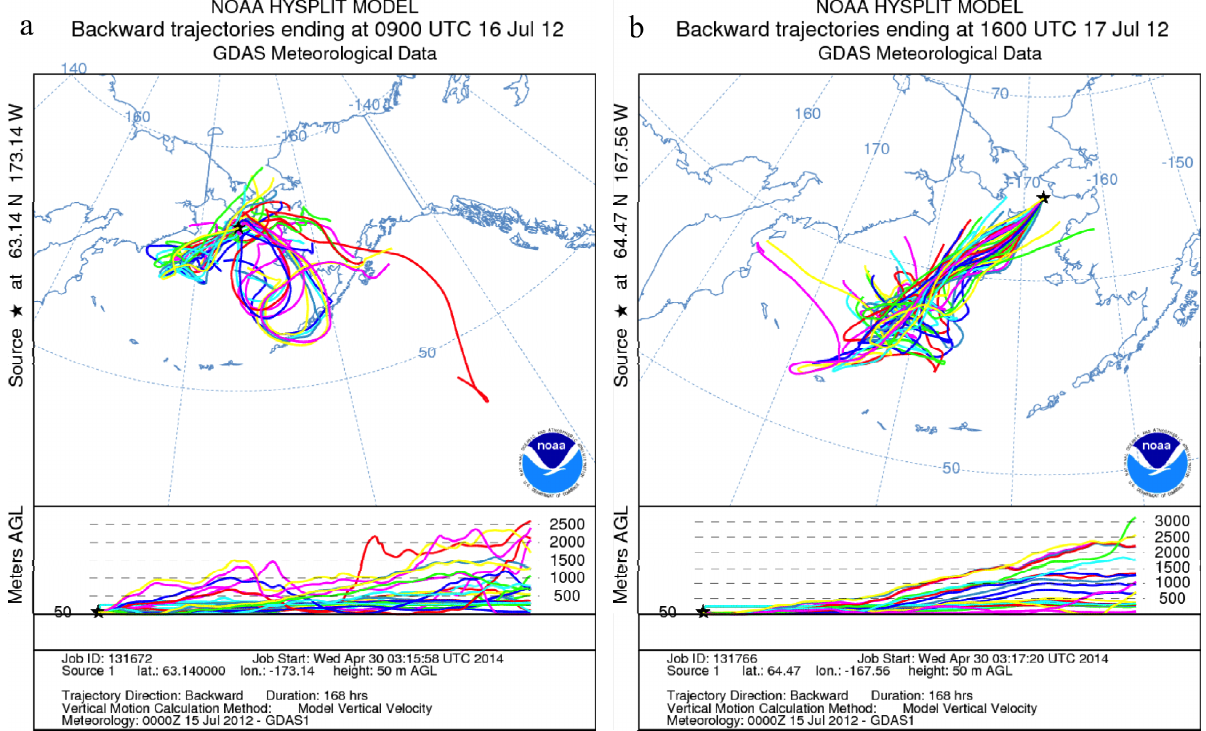
Figure 5. Seven-day air mass backward trajectories of some special locations around the Bering Strait and the Kamchatka Peninsula. ( a , b , c ) Departing route, ( d , e , f ) Return